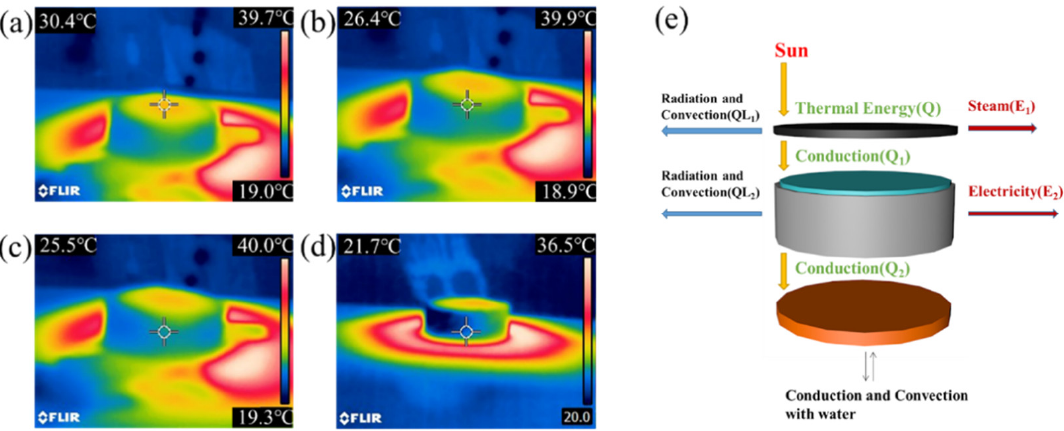
Figure 7. ( a – d ) Top-down infrared thermal images of the thermoelectric device; ( e ) Heat transfer mechanism of the thermoelectric device.